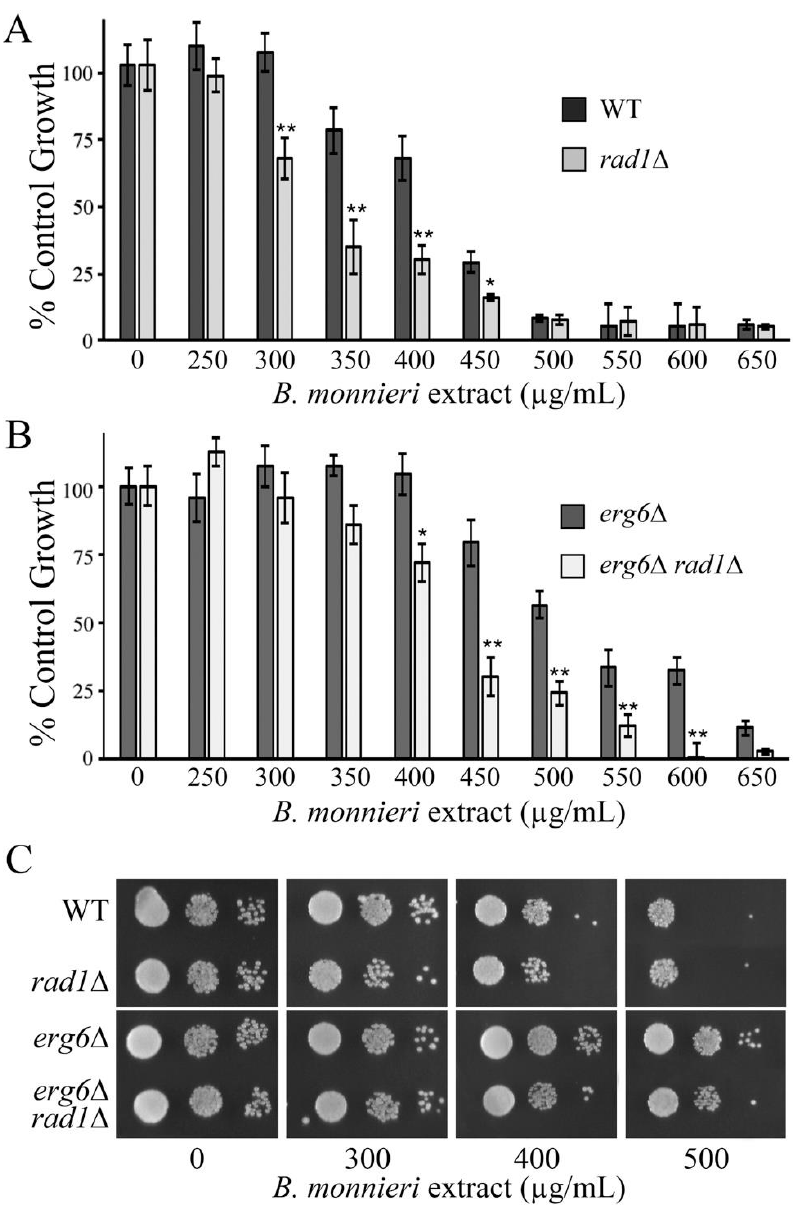
Figure 7. Effect of sterols on the toxicity of B. monnieri extracts in yeast deleted for RAD1 . ( A , B ) Yeast strains WT, rad1 ∆ (12806), erg6 ∆ (PJ100), and rad1 ∆ erg6 ∆ (PJ101) were grown in synthetic medium with 2% glucose in the presence of 2% DMSO and 0.2% Tween 80 (vehicle control) or B. monnieri extracts at the concentrations listed. Values are mean ± SD ( n = 3). Growth was monitored by measuring OD at 600 nm with vehicle control (0) set at 100%. Statistical analysis employed Student’s t-test with ** p < 0.01, * p < 0.05. ( C ) Serial dilutions of liquid cultures from A and B were spotted onto solid synthetic medium with 2% glucose as described in Figure 4. Samples were incubated for 3 days and photographed.